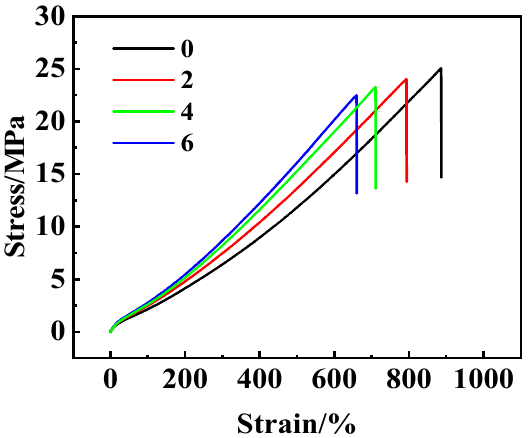
Figure 5. Stress–strain curves of NR/UHMWPE resin powder composites. Table 6. Mechanical properties of NR/UHMWPE resin powder composites.